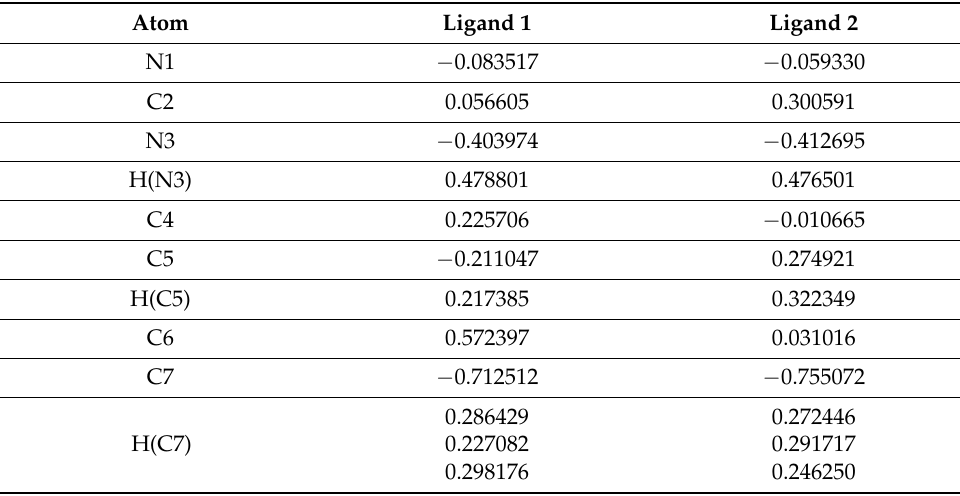
Figure 14. MEP surface of the two organic cations in ( 2 ). Table 9. Mulliken charge distribution of organic atoms and water in ( 2